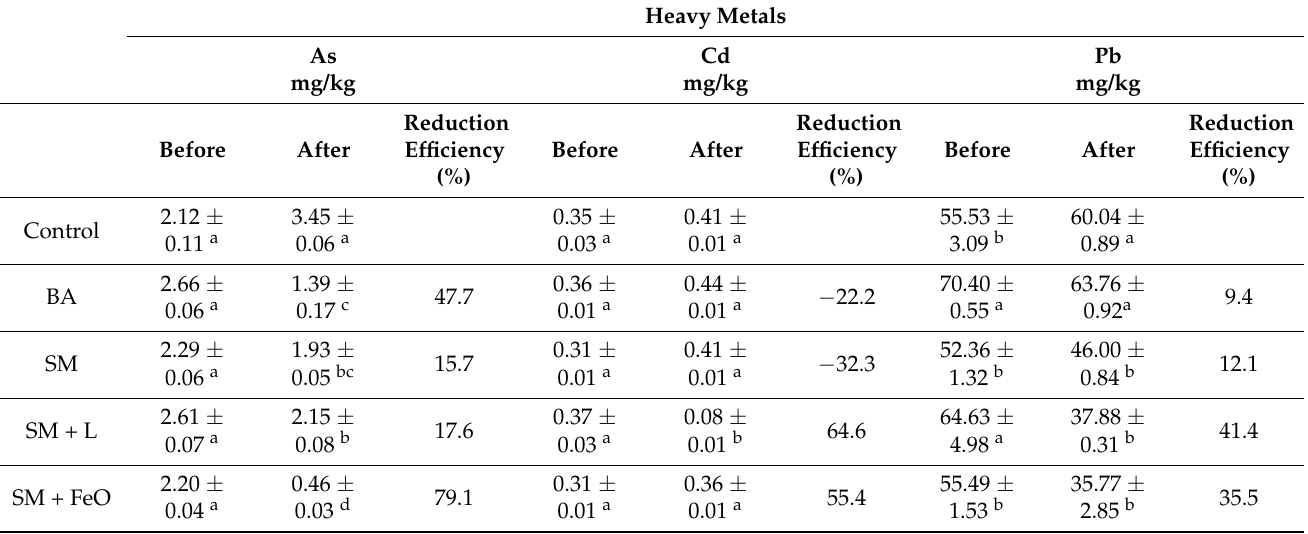
Table 4. Bioavailable concentration of heavy metals before and after cultivation in upland